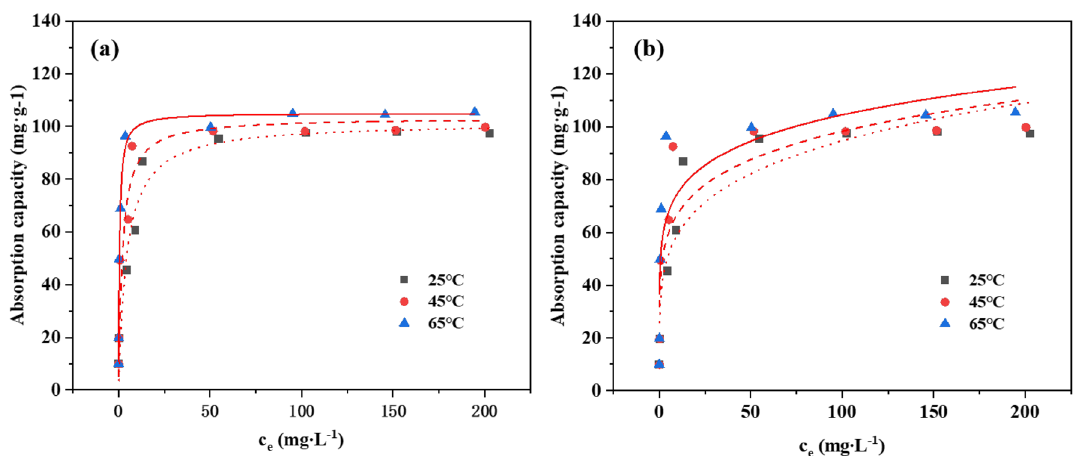
Figure 13. Isotherm models for Cd 2+ adsorption onto MRM: ( a ) Langmuir isotherm model and ( b ) Freundlich isotherm model at T = 25–65 °C, Cd 2+ concentration = 0–300 mg L −1 , dosage = 0.1 g L −1 , pH = 6, and contact time = 240